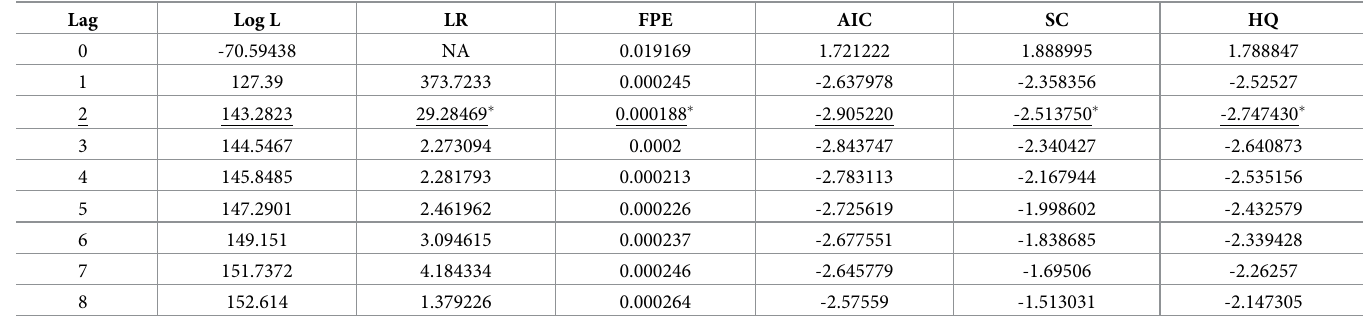
Table 4. Delay order table of VAR model.